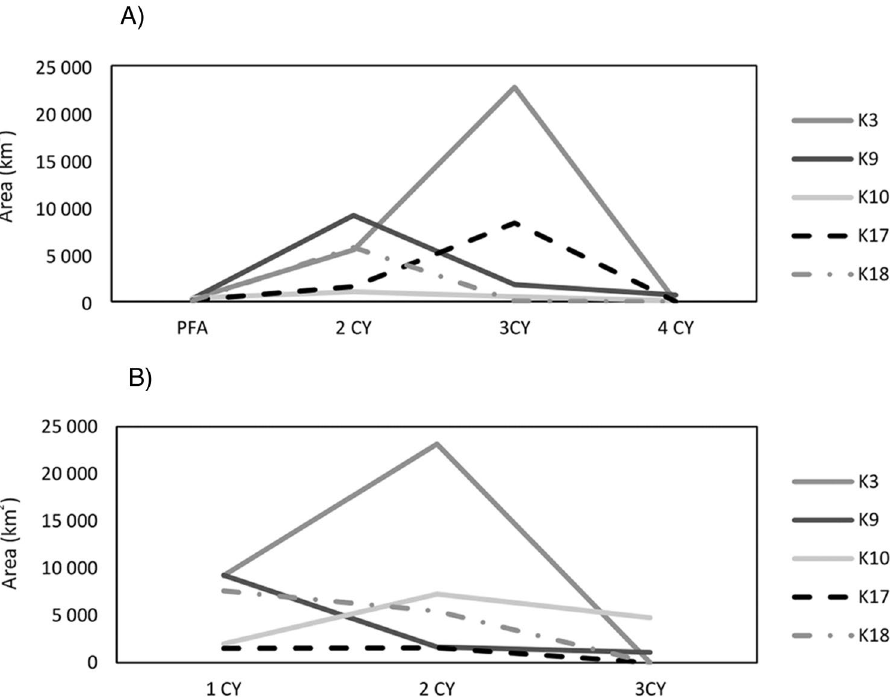
Figure 4. Line chart showing the changes in the size of ( A ) summer and ( B ) winter home-range throughout the life span of five tagged Black Kites. PFA—post fledging area; CY—calendar year.